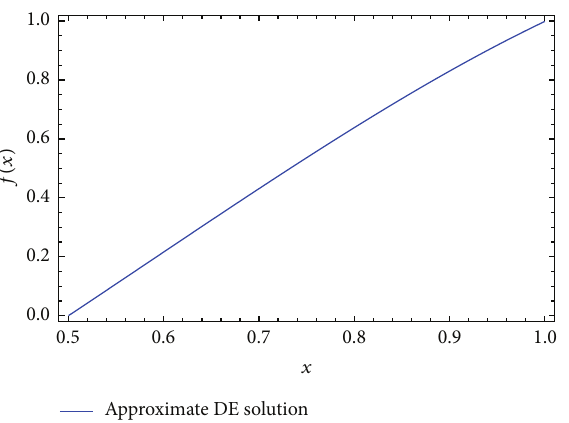
Figure 9: Approximate solution for 0.1𝑦 󸀠󸀠 + (1 − 𝑦 2 )𝑦 󸀠 + 𝑦 = 0 with 𝑦(0) = 0.5 and 𝑦 󸀠 (0) = 1